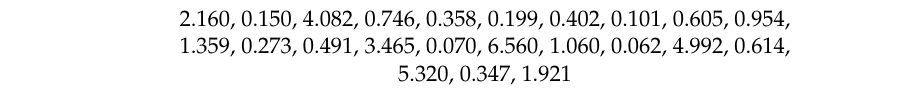
Table 2. Second reactor pump failure time